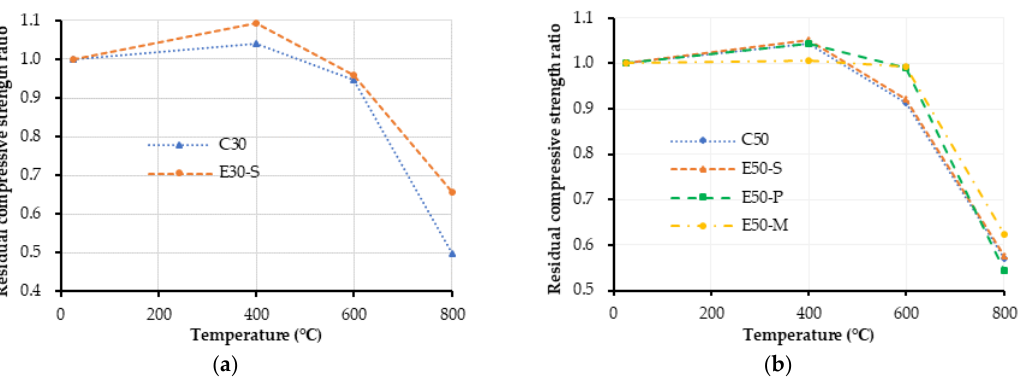
Figure 5. Comparison of residual compressive strength ratio of LWC specimens: ( a ) low-strength and ( b ) medium-strength